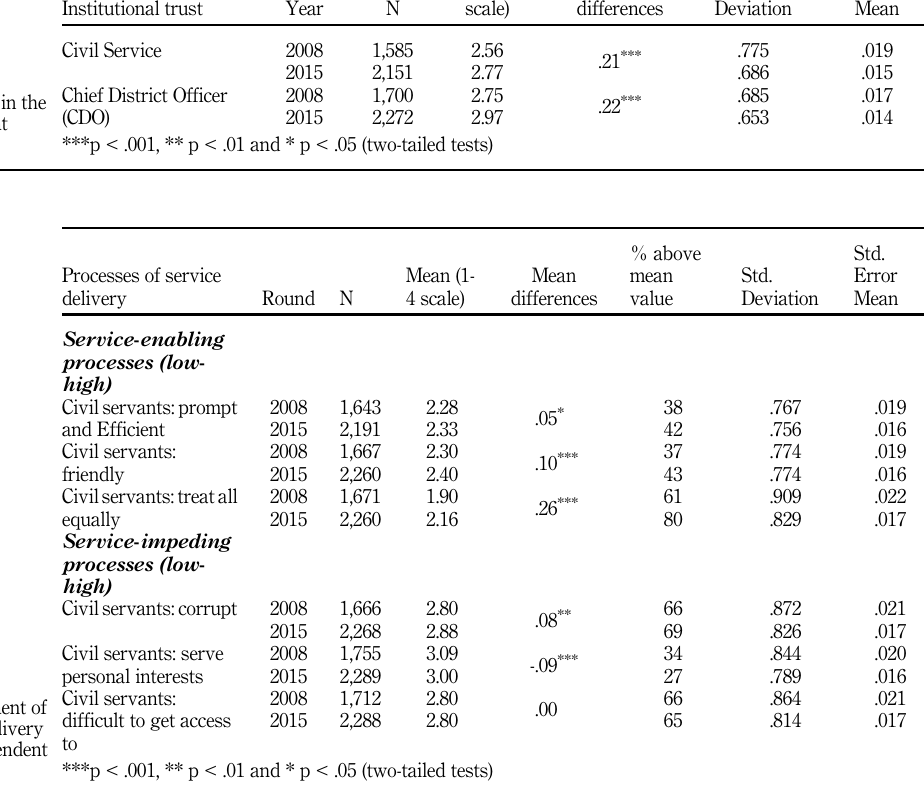
Table 13. Citizens ’ assessment of public service delivery processes(Independent t-test)